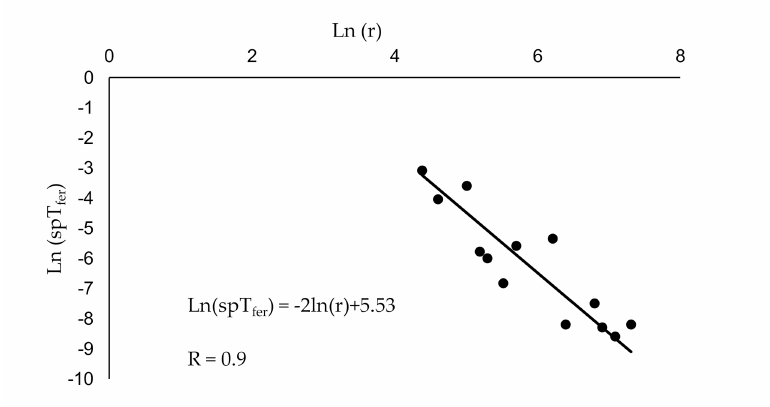
Figure 5. Log-log plot of proportion males caught in pheromone-baited traps located at various distances (r) from male moth release points. Black line is the least square fit to the experimental data